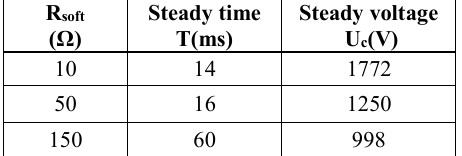
Fig. 5. The capacitor voltage of different soft-start resistor. Table 2. The Influence of soft-start resistor on charge voltage.